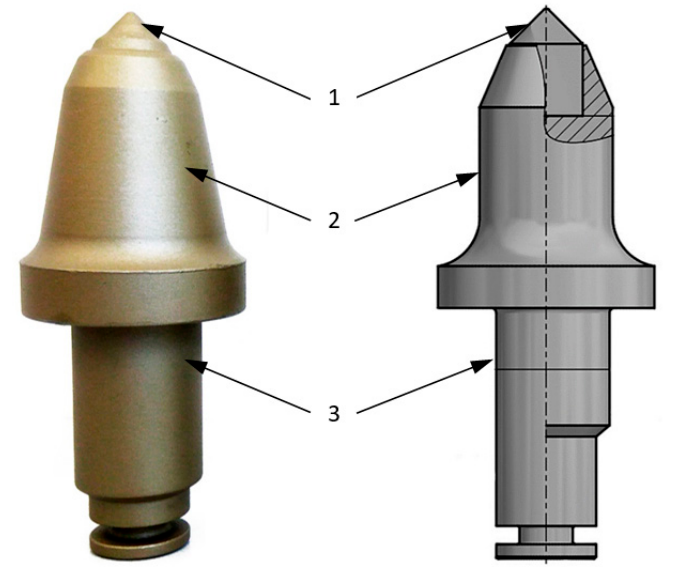
Figure 1. Construction of a conical pick: 1—tip, 2—working part, 3—holder part [4].